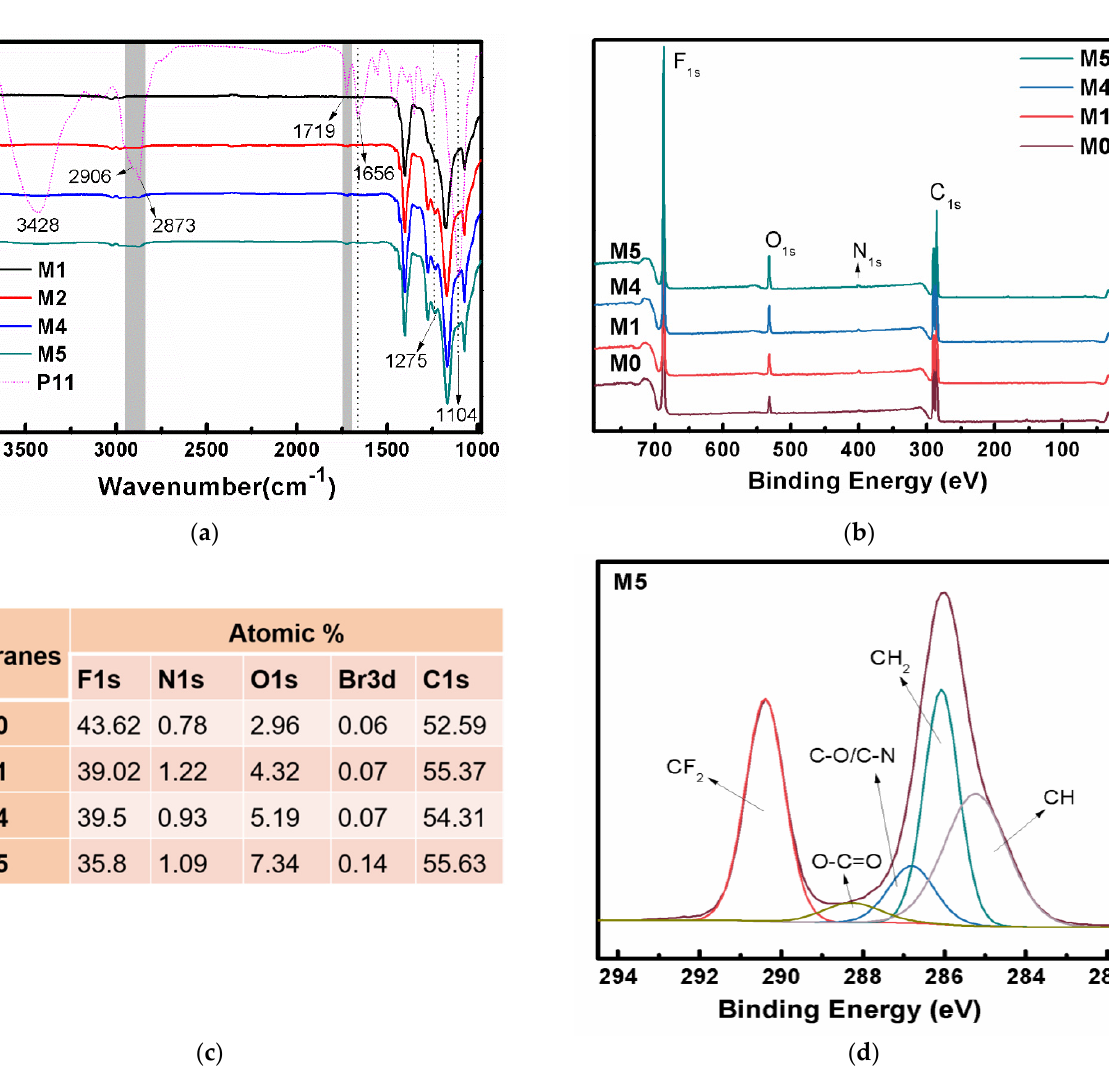
Figure 2. ( a ) FT-IR spectra of P11 and membranes; ( b ) full XPS spectra of membranes; ( c ) the elemental composition of membrane surface; and ( d ) the C core layer XPS spectrum of M5.